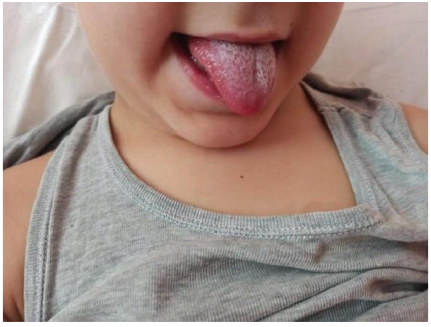
Figure 2: Strawberry